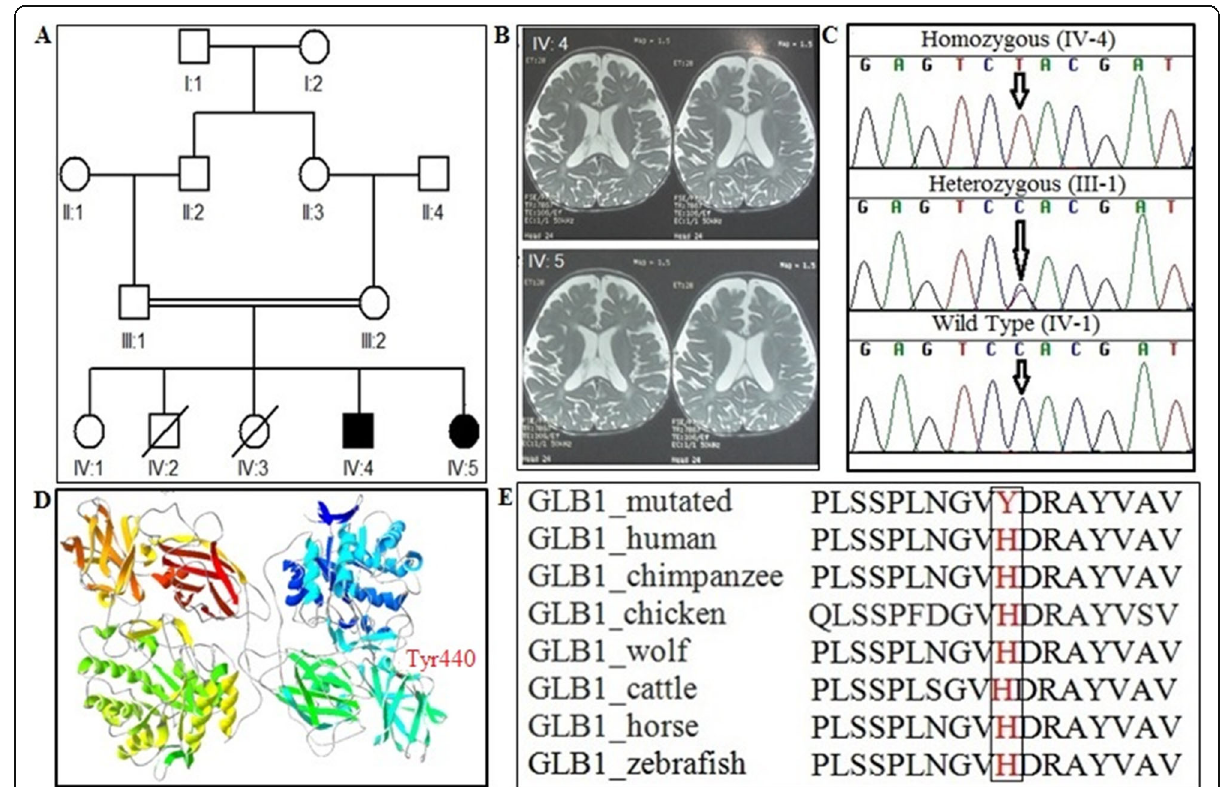
Fig. 2 a Pedigree of the family MR-7 showing pattern of autosomal recessive inheritance. Clear circles and squares symbols represent normal and filled circles and squares showing affected individuals. b Brain MRI of T1-weighted image of patient (IV: 4) showing abnormal deep white matter signal in subcortical, prominent ventricular and extra vent spaces. Brain MRI of patient (IV: 5) showing cerebellar emotional changes with reduced periventricular deep white matter. c Sequence chromatograms of the GLB1 gene indicating the homozygous mutation (c.C1318T: p.His440Tyr) in affected patients (IV: 4), wild type (IV: 1) and heterozygous carrier parents (III: 1). d Protein model of the gene was showing the mutated protein (Tyr440). e Multiple alignment of the GLB1 gene across different orthologous species were showing complete conservation at the site of